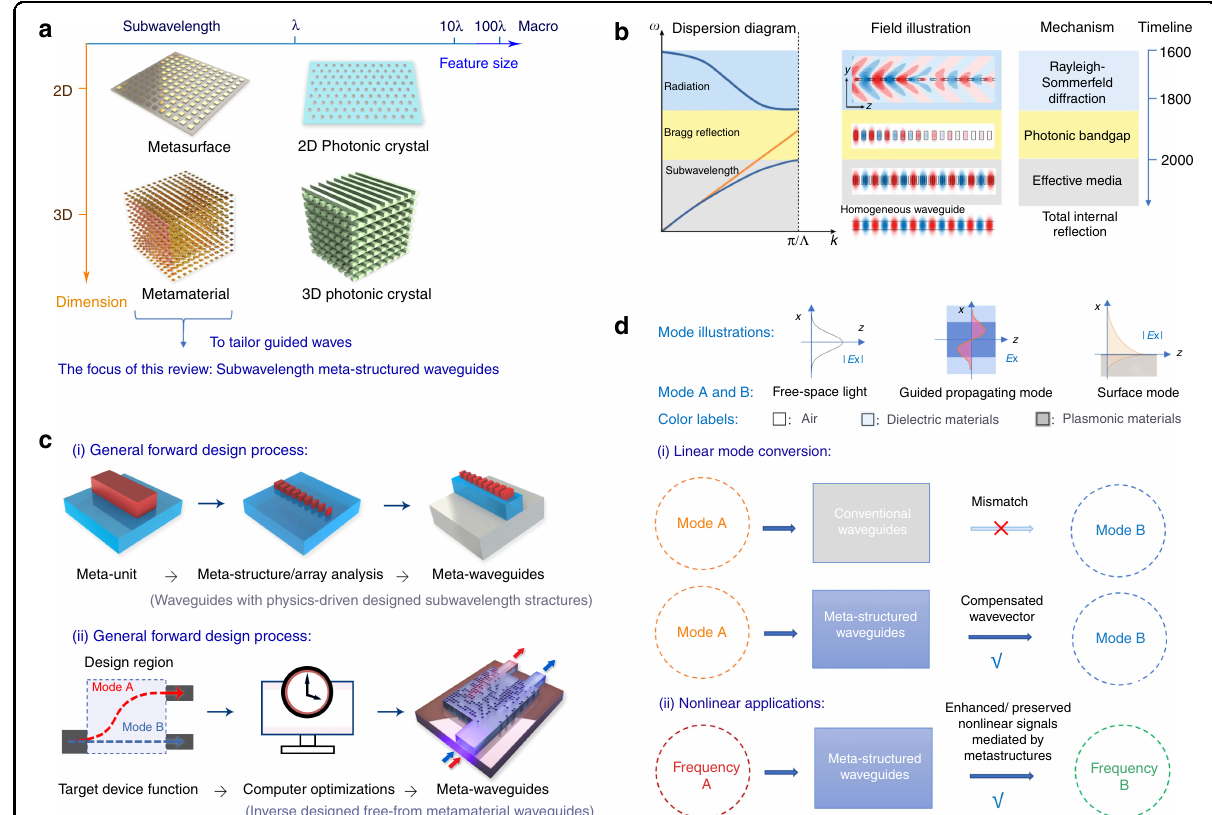
Fig. 2 Meta-optics fundamentals and its implementation on waveguides. a Concepts of photonic crystals, metamaterials and metasurfaces. b Comparisons of light propagating in structured planar waveguides with different periodic feature size 12 . Left panel: schematic dispersion diagram. Right panel: Corresponding electric fi eld distributions at three different regimes, where black rectangles denote silicon segments. (Reproduced from ref. 12 ) Waveguiding mechanisms and rough development timeline are appended 157,537 – 539 . c Two general directions to design meta-waveguides: physics intuition-based forward designs and inverse-design methods 15 . d General operation